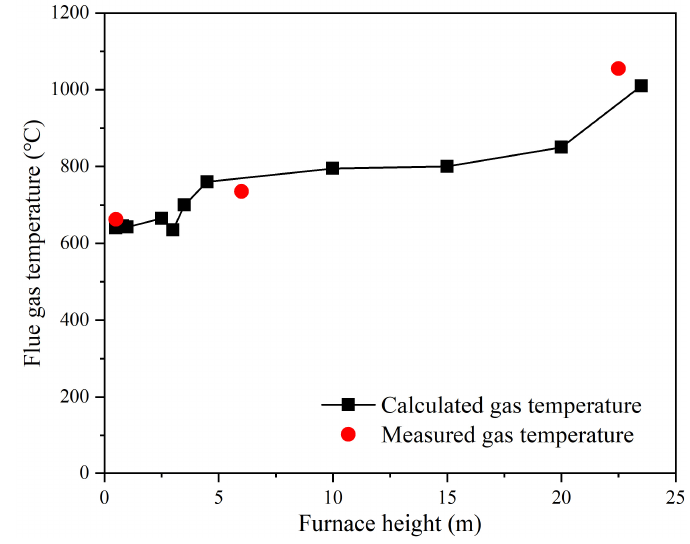
Figure 5. The average temperature of flue gas distributed along the furnace height in Case 1.